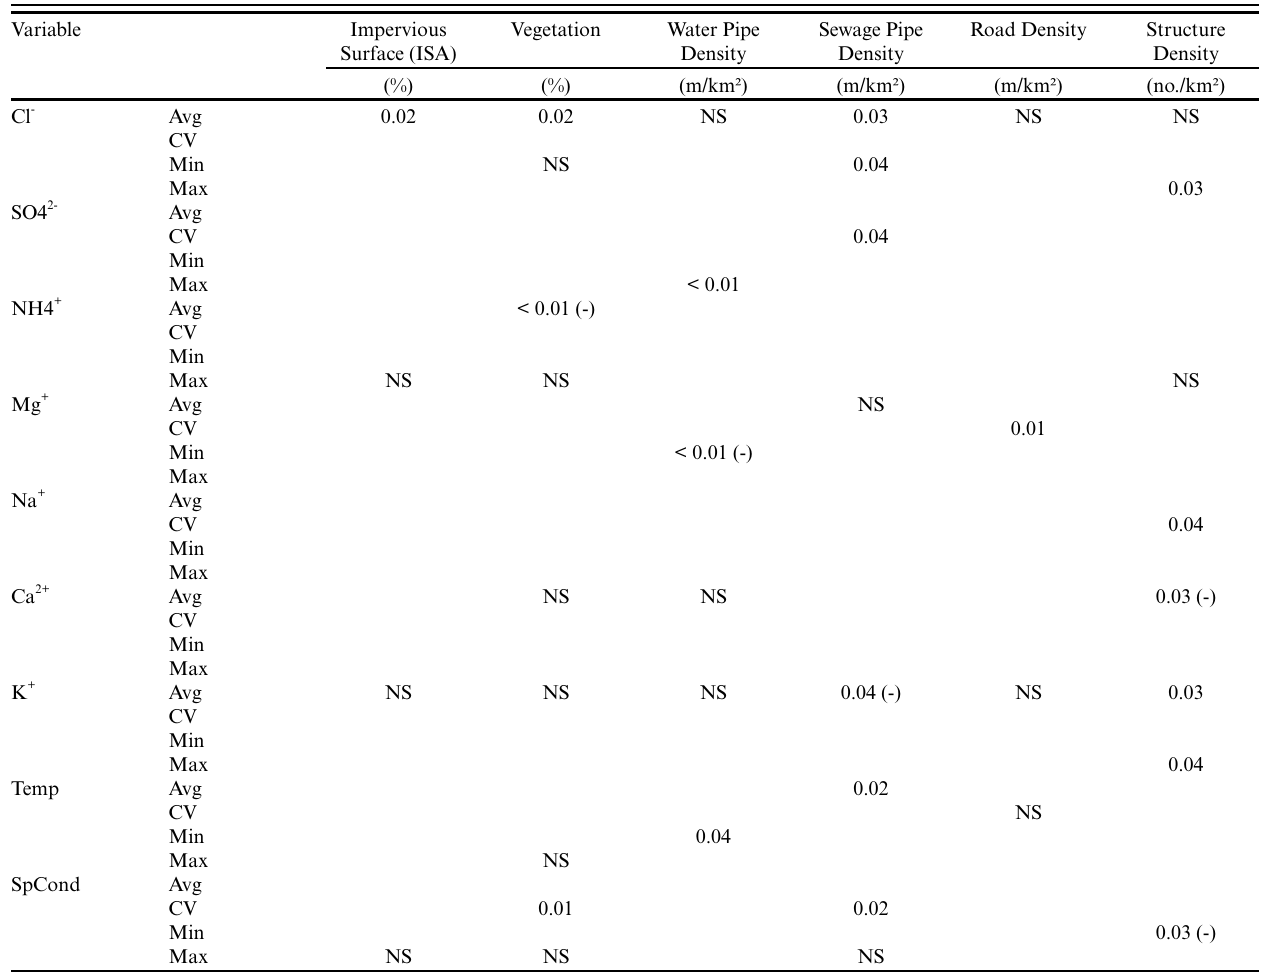
Table 3 . P values for stepwise multiple regression results between water variables and subwatershed characteristics. NS refers to a variable that entered the model, but was not significant at p < 0.10. Values followed by (-) indicate negative relationships, all others being positive. Avg = average value, CV = coefficient of variation, Min = minimum value, Max = maximum value, Temp = temperature, SpCond = specific